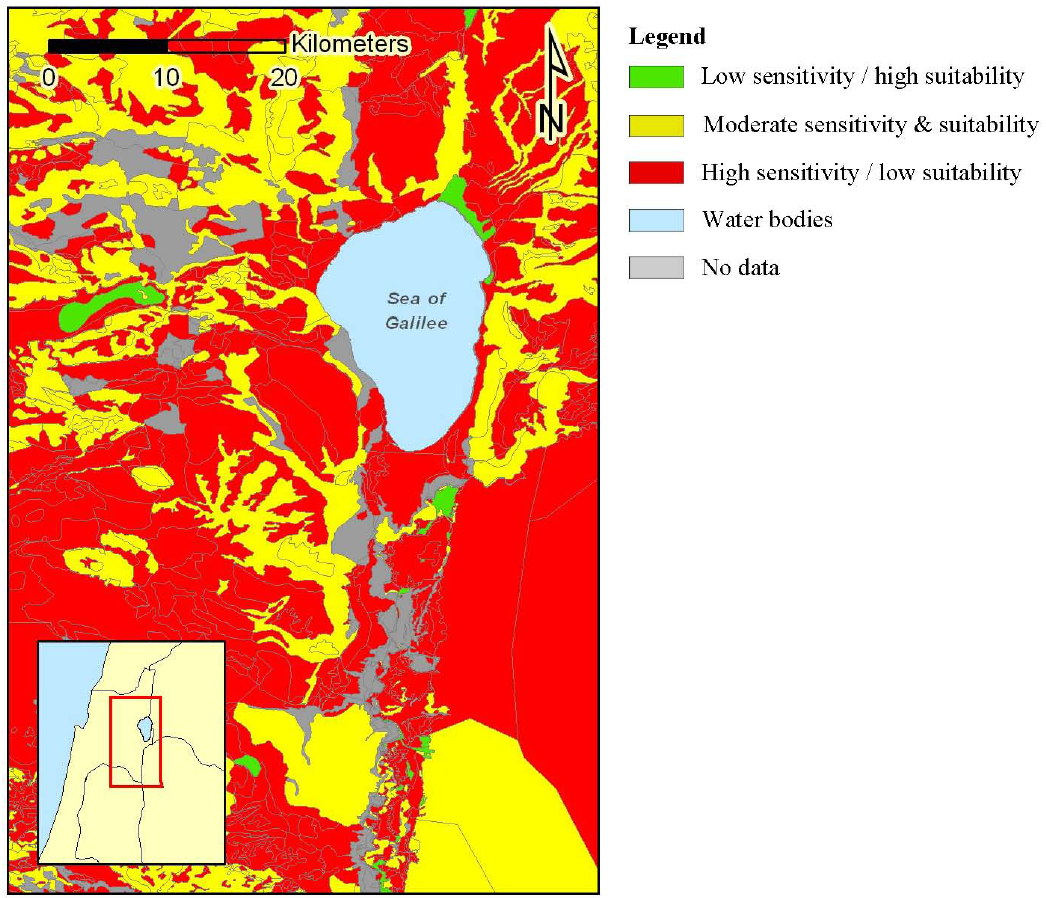
Figure 4. Cut-out of the risk assessment map visualizing sensitivity C: Sensitivity towards salinization (scale 1: